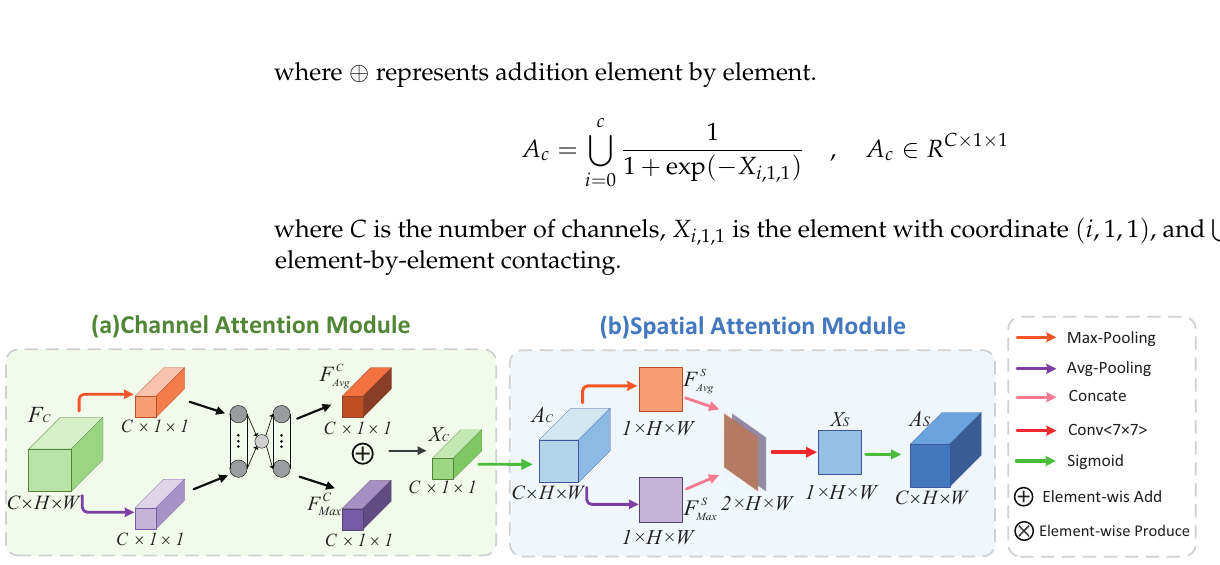
and F S (the Avg Max